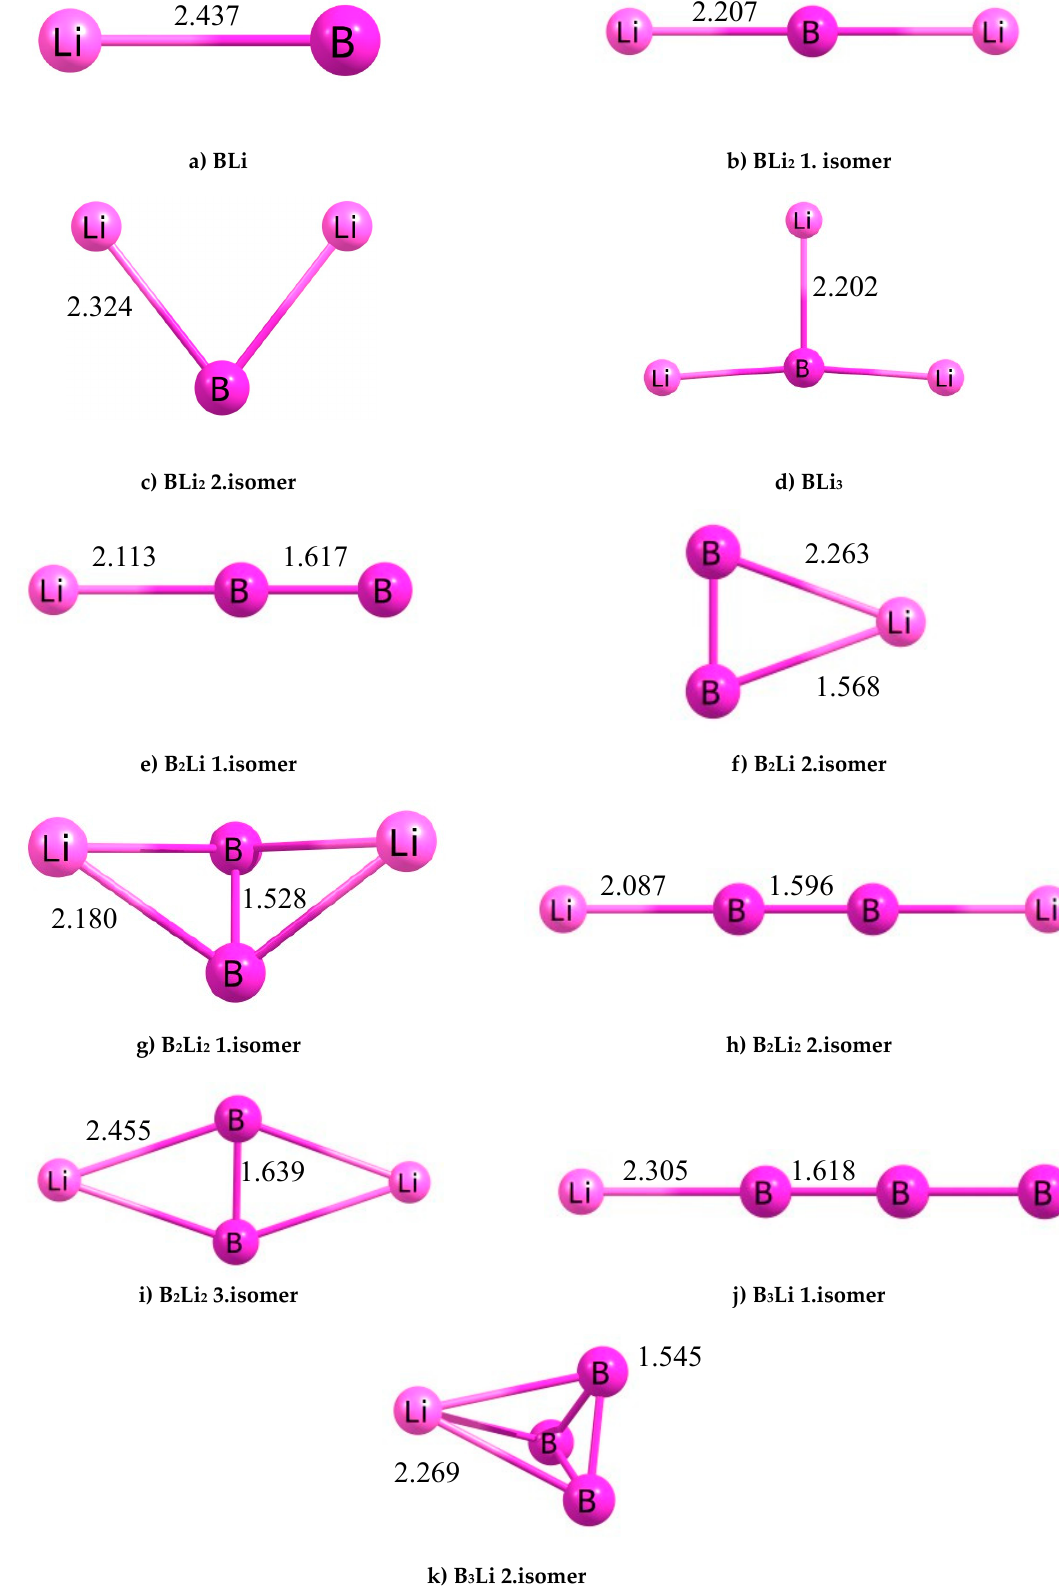
Figure 1. The B x Li y (x = 1–3, y = 1–3) molecules. Table 1. Average Bond Lengths of the B x Li y clusters.